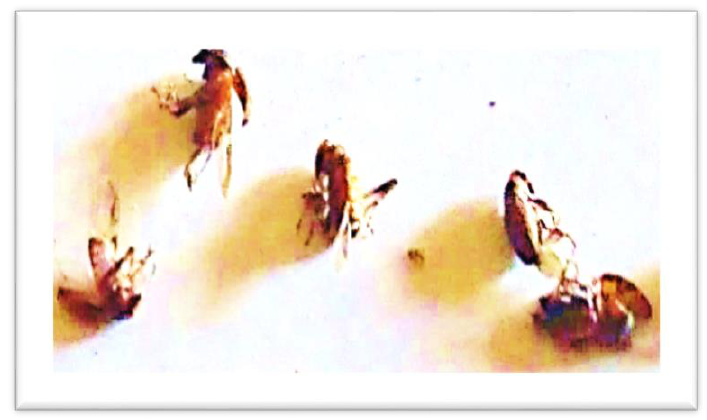
Figure 7. Tribolium casteneum on the stored breadfruit seeds after four weeks.